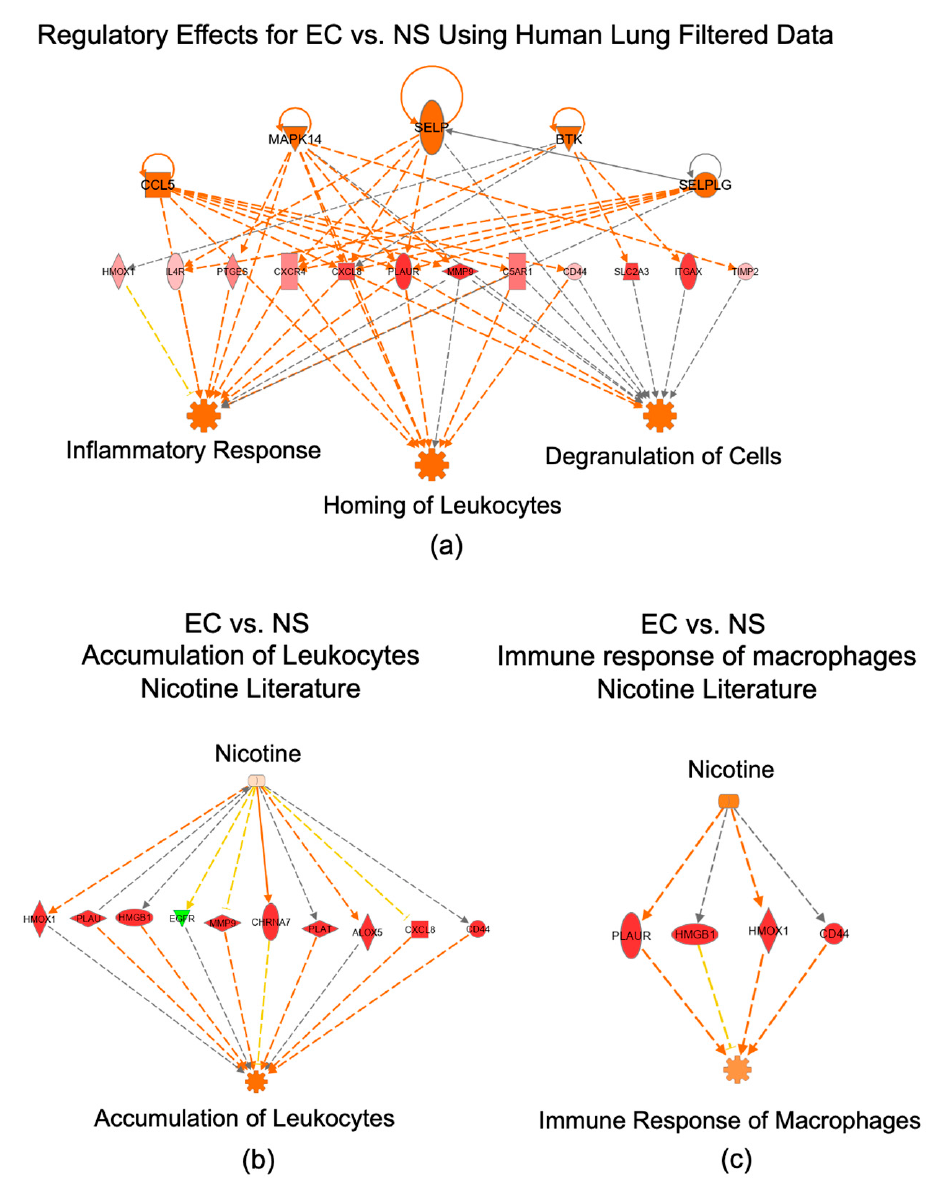
Figure 6. Evidence of an immune response in the EC vs. NS set. ( a ) IPA regulator effects analysis in the EC vs. NS set. Diagram shows predicted upstream regulators (upper row) and predicted downstream processes and functions (lower row) based on DEGs in our data (middle row). ( b ) “Accumulation of Leukocytes” generated by overlaying our data on the nicotine literature. ( c ) “Immune Response of Macrophages” generated by overlaying our data on the nicotine literature. Upregulated DEGs are pink-to-red depending on fold-change, whereas green DEGs indicate downregulation. Orange arrows represent predicted activation, yellow arrows indicate non-consistent activation and grey arrows represent effect not predicted.